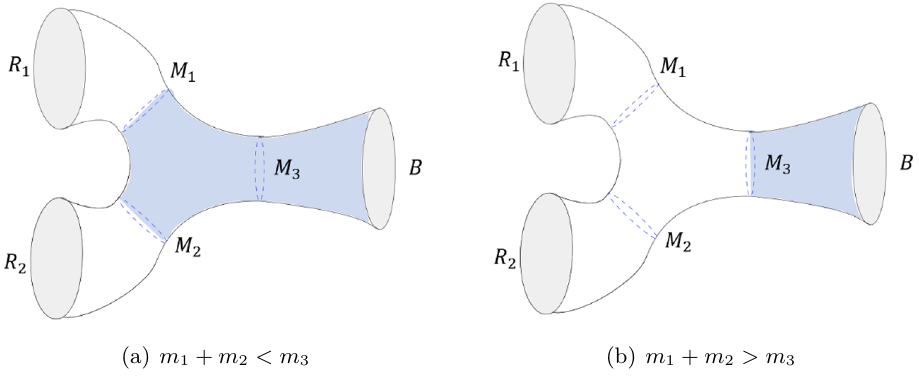
Figure 1 . The 3-side wormhole has three asymptotic boundaries R 1 , R 2 and B . The entanglement wedge of B is the blue shaded region in the figure. We have m 1 + m 2 < m 3 at early time of the evaporation and m 1 + m 2 > m 3 at late